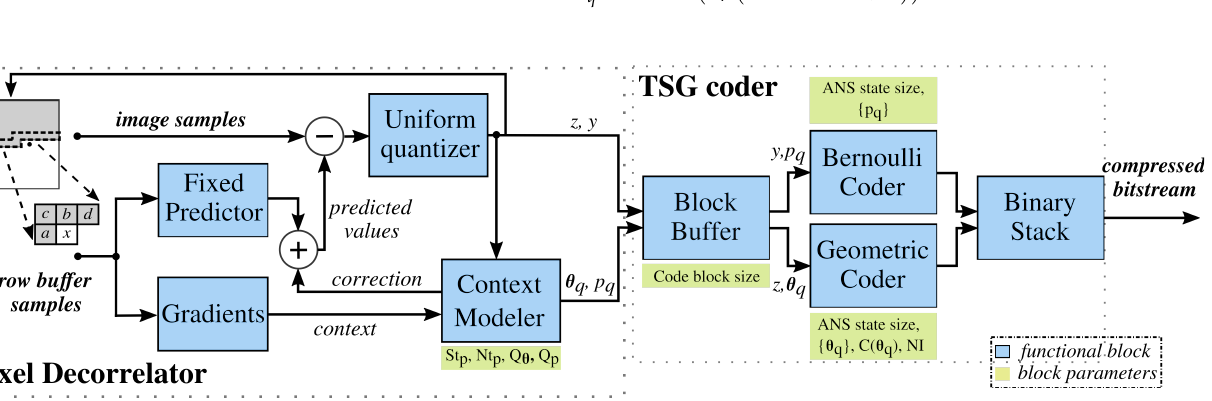
Figure 1. LOCO-ANS block diagram. Source adapted from